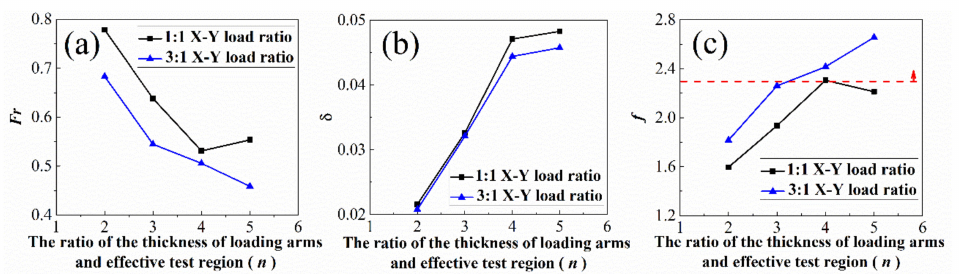
Figure 3. The relationship between ( a ) the stress concentration factor, ( b ) the stress variation coeffi- cient, and ( c ) the weighted design function and the ratio of the thickness of loading arms and effective test region. The red line presents the design critical value f cri .